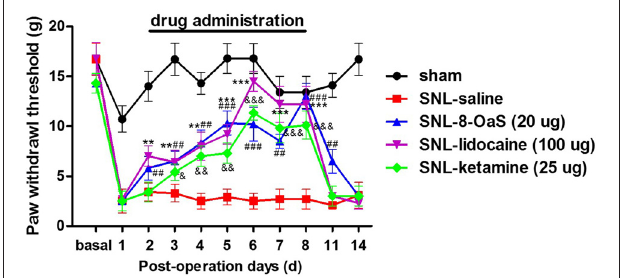
FIGURE 2 | The analgesic effects of lidocaine, ketamine and 8-OaS in the SNL model. Treatments with lidocaine, ketamine and 8-OaS for consecutive 7 days decreased SNL-induced mechanical hypersensitivity, ∗∗ P < 0.01 and ∗∗∗ P < 0.001, SNL-lidocaine vs. SNL-saline group; & P < 0.05, && P < 0.01 and &&& P < 0.001, SNL-ketamine vs. SNL-saline group; ## P < 0.01 and ### P < 0.001, SNL-8-OaS vs. SNL-saline group. n = 6 in each